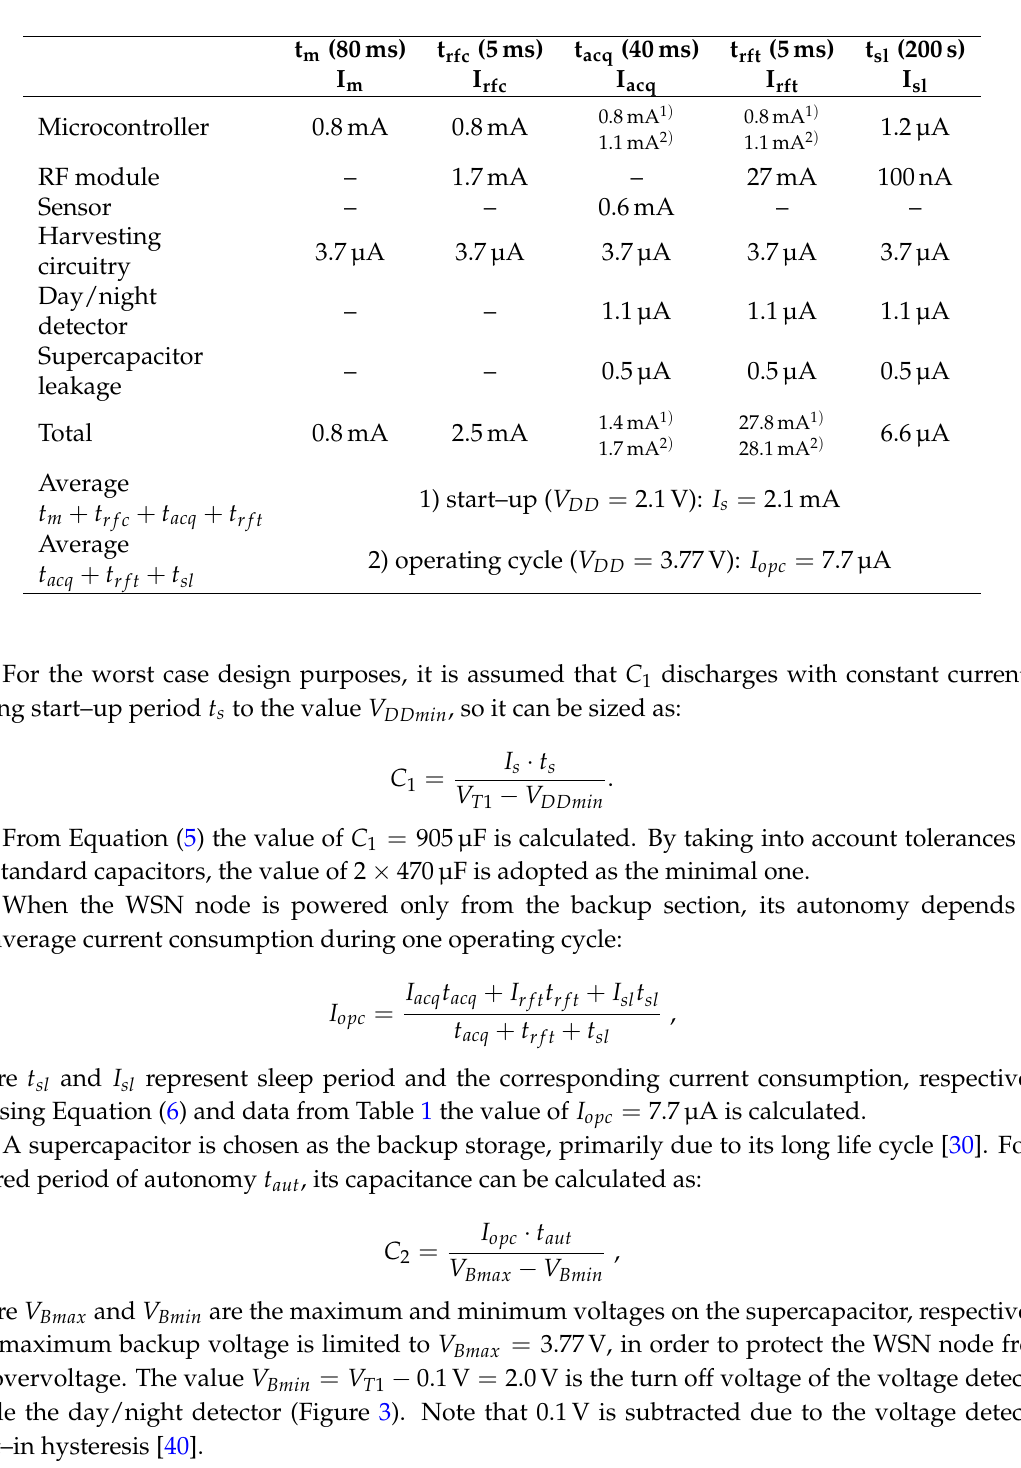
Table 1. Current consumption of components during distinctive periods of the system